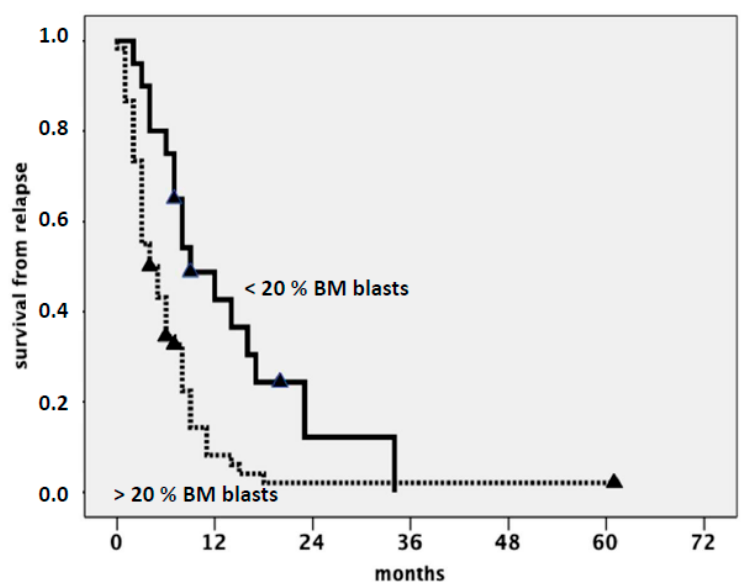
Figure 2. Survival from relapse according to bone marrow blast count at relapse (> or 